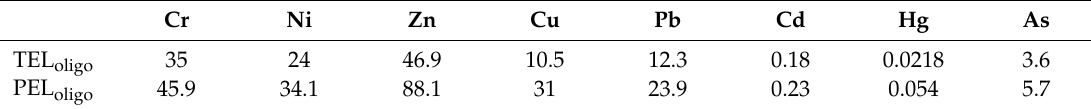
Table 3. TEL oligo and PEL oligo thresholds determined for the metals Cr, Ni, Zn, Cu, Pb, Cd, Hg and as ( µ g / g dry weight). ( μ g/g dry weight).